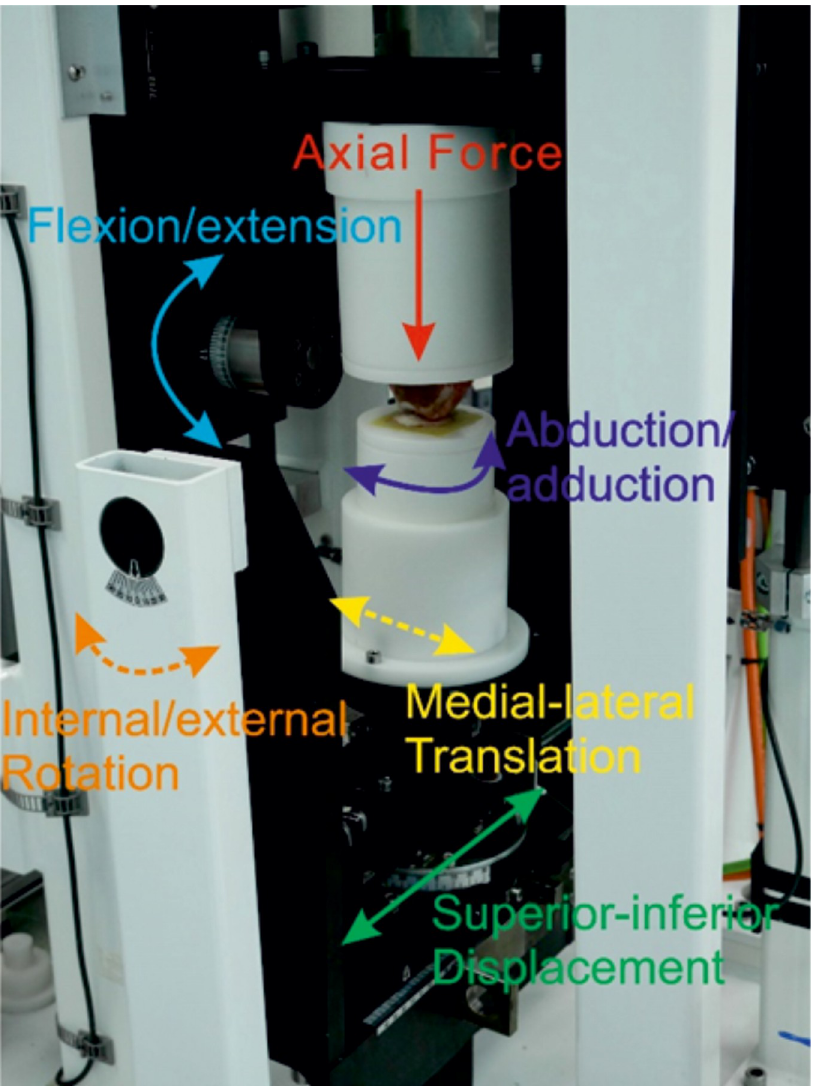
Fig 1. A porcine PFJ mounted in a single station knee simulator. The solid arrows represent controlled/driven axes (AF, FE, AA, SI), the dashed lines represent either uncontrolled axes (M-L) or axes constrained using springs (IE). During the simulation, the joint was enclosed within a gaiter filled with 25% (v/v) bovine serum in PBS.